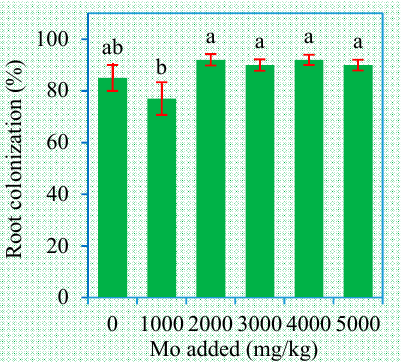
Figure 1. Root colonization rate (mean ± SE, n = 4) of the inoculated sweet sorghum exposed to different concentrations of Mo. Different letters over the bar represent significant differences between the means among different treatments using one-way ANOVA followed by Duncan’s multiple range test ( p < 0.05).